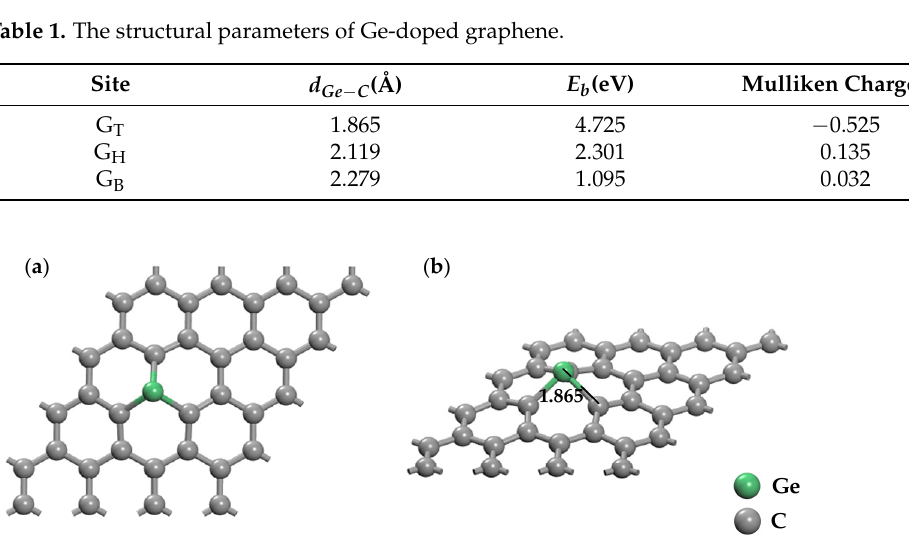
Figure 4. The total density of state ((TDOS) (a) and partial density of state (PDOS) (b) of GeG sys- tem at T doping site.